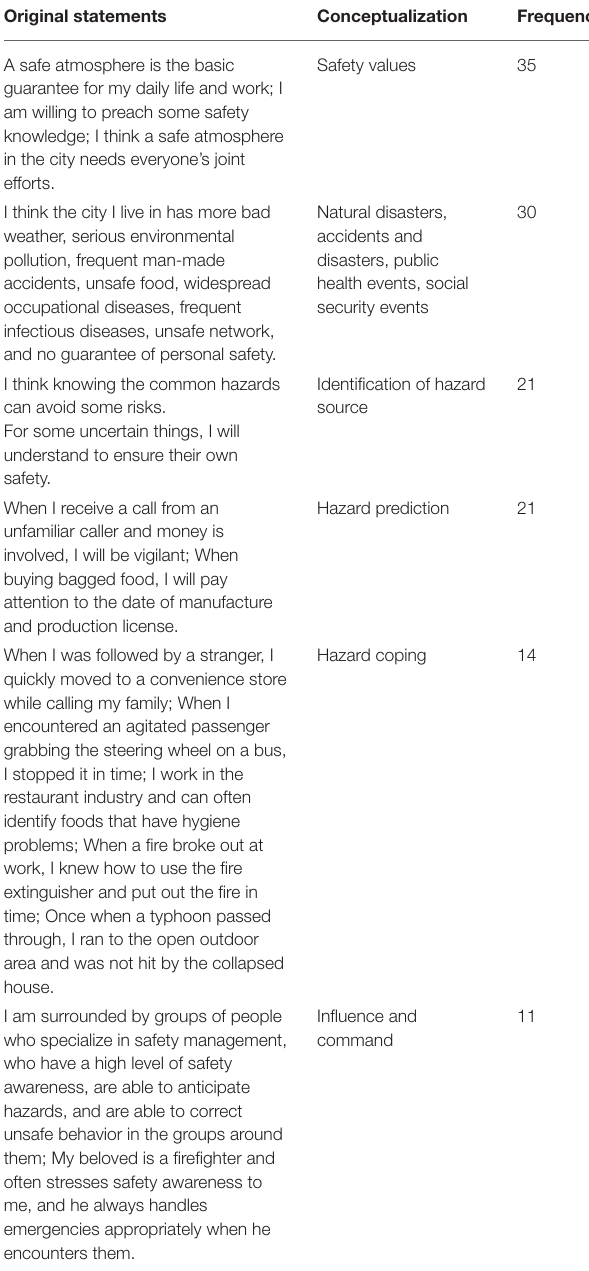
TABLE 3 | Classification of semantically similar